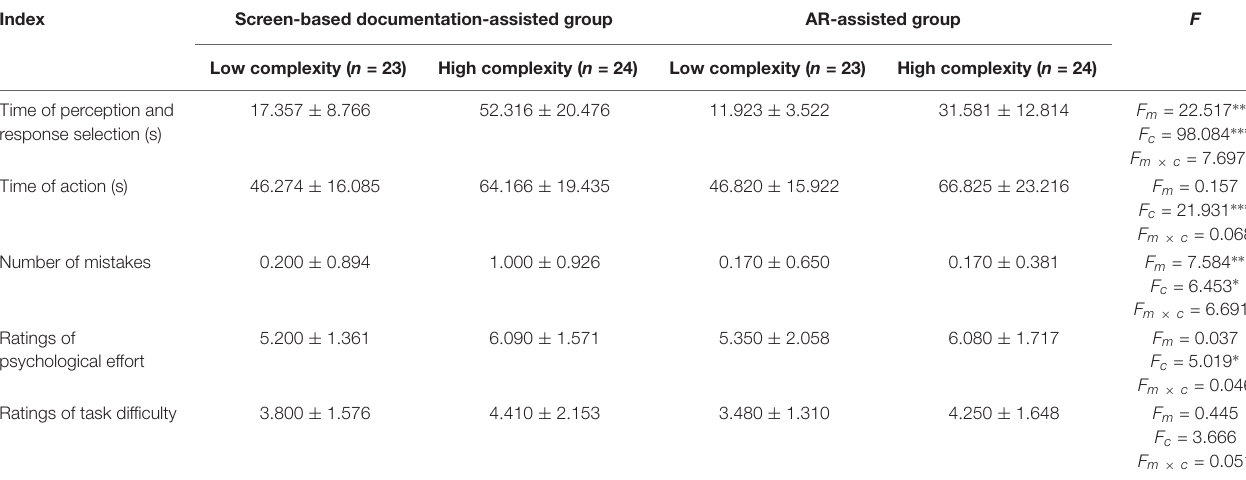
TABLE 3 | Performance data of the joining subtask with various complexities in different stages under two assistance